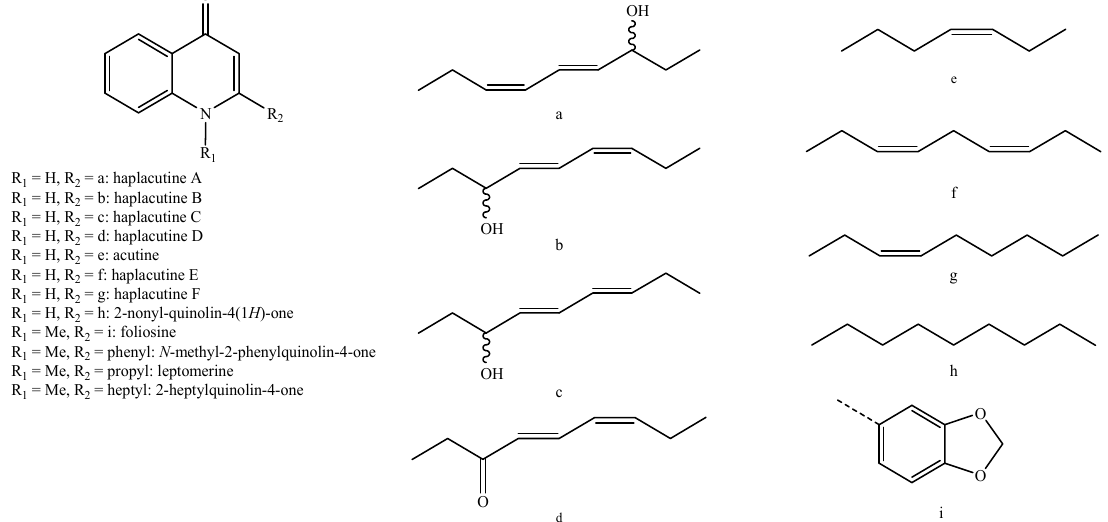
Figure 9. Structure of the alkaloids identified in Haplophyllum species—part 5.